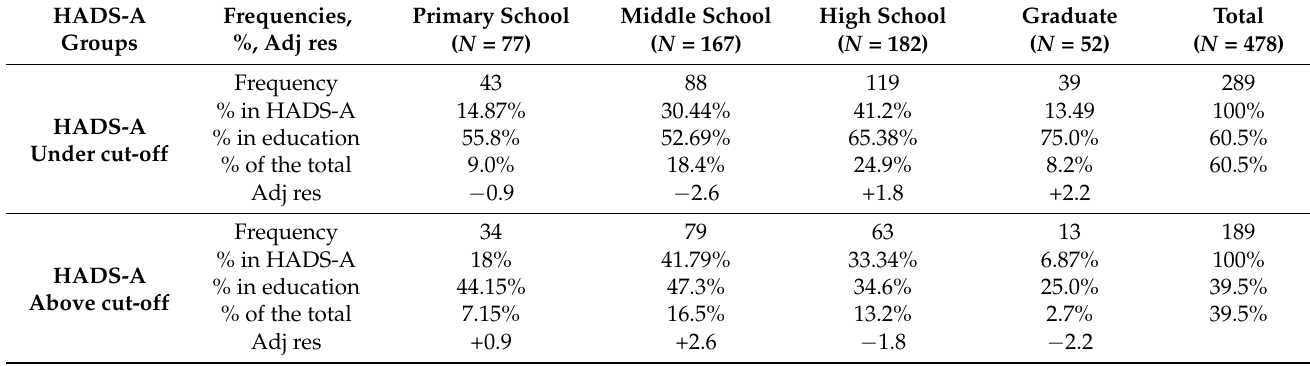
Table 4. Contingency table with frequencies of patients above/under the HADS-A cut-off scores and the level of education. HADS-A